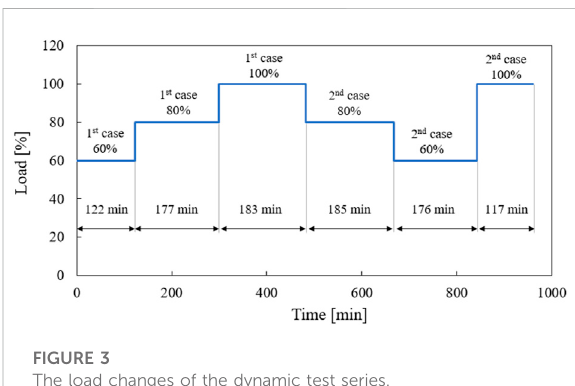
FIGURE 3 The load changes of the dynamic test